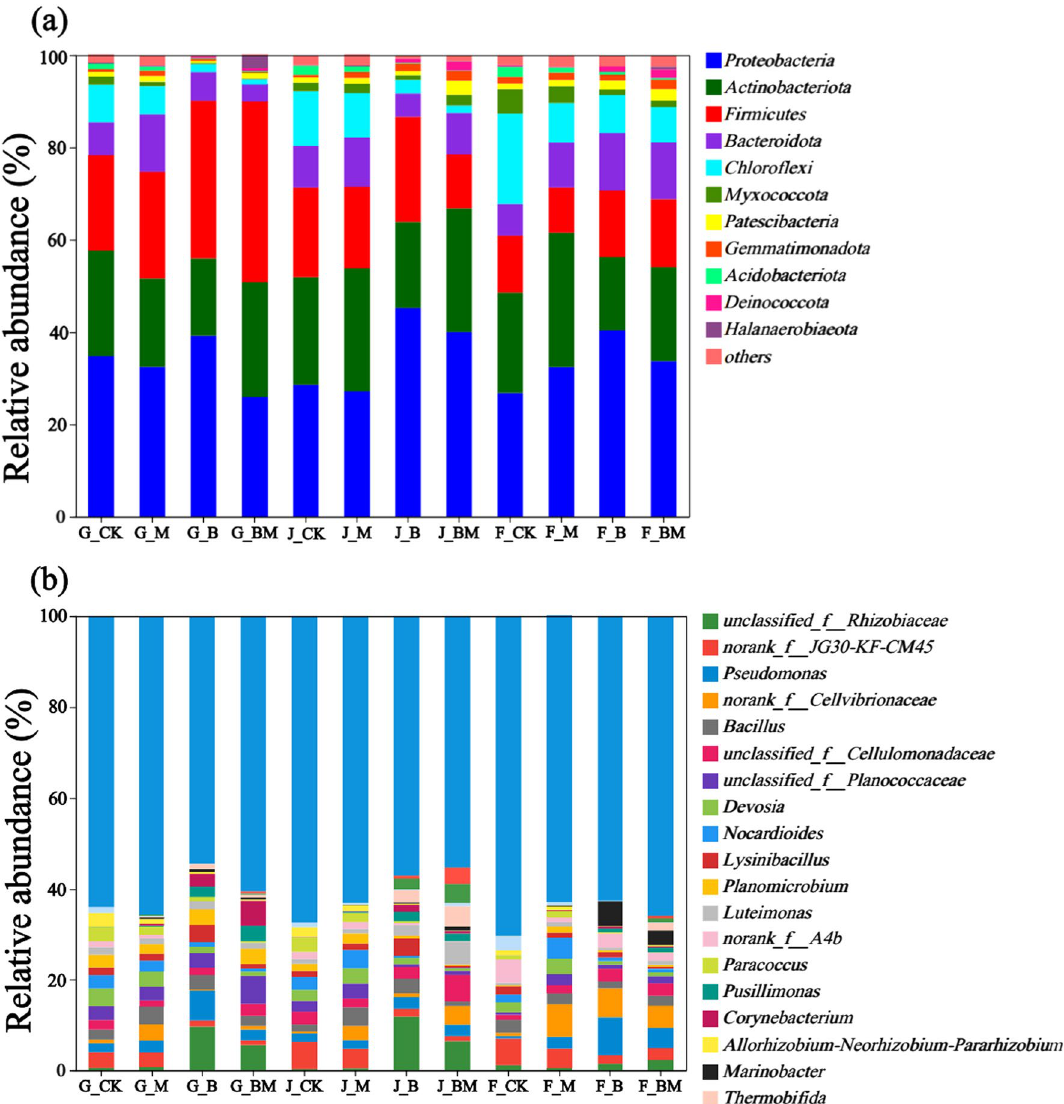
Fig. 6 Bacterial abundance at phyla level ( a ), and bacterial abundance at genus level ( b ) in different treatments during composting. CK: sheep manure corn straw; M: CK 0.01% compound microbial agents; B: CK + + compound microbial agent to 0.1% biochar before being naturally